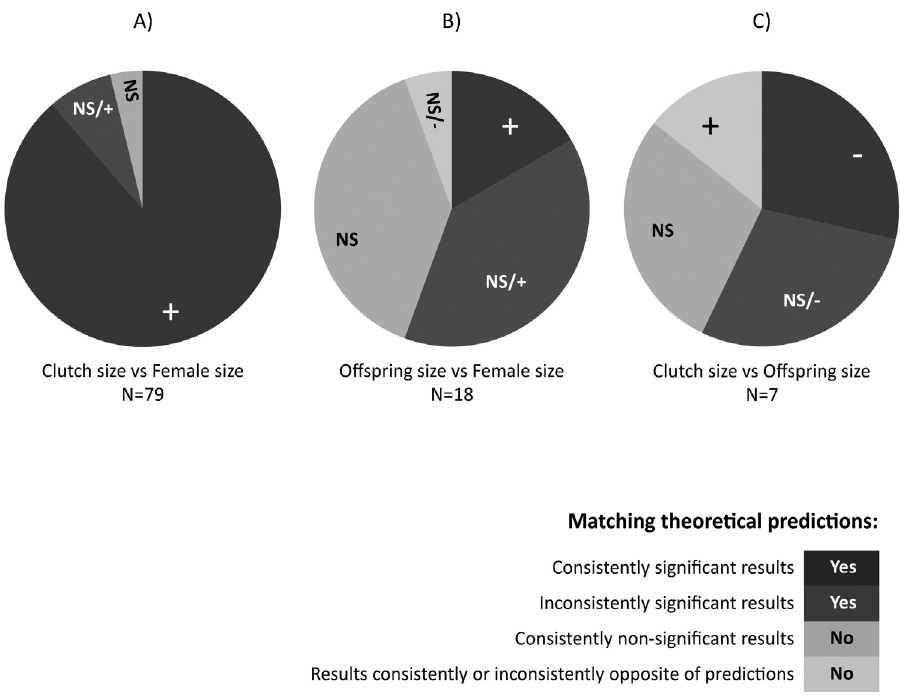
Figure 3. The literature search identified 79 species of isopods that were studied with respect to at least one of the following relationships: clutch size with female size ( A ), offspring size with female size ( B ), and clutch size with offspring size ( C ). Each graph shows how frequently a given nature of each relationship was found among the studied isopod species. The exact number of species for which the relationships A, B, C were evaluated is given by N. For each type of the relationships A, B, C each species was clas- sified according to the nature of this relationship. If a relationship for a given species was consistently reported to be significantly positive, negative, or non-significant, the species was marked by a positive (+) or negative (-) symbol or by NS. Species for which mixed results were reported in the literature, showing either non-significant/significantly positive relationships or non-significant/significantly negative relation- ships, were marked by NS/+ or NS/-, respectively. Colour intensity indicates values along a 1–4 scale of confidence to the support provided by each relationship pattern (+, -, NS, NS/+ and NS/-) to hypotheses (i–iii). Relationship A : a positive relationship predicted between female body size and clutch mass/clutch size (hypothesis i). Relationship B : a positive correlation predicted between the average offspring mass in a brood and female body mass (hypothesis ii). Relationship C : a negative correlation predicted between the mean mass of offspring and the number of offspring per brood (hypothesis